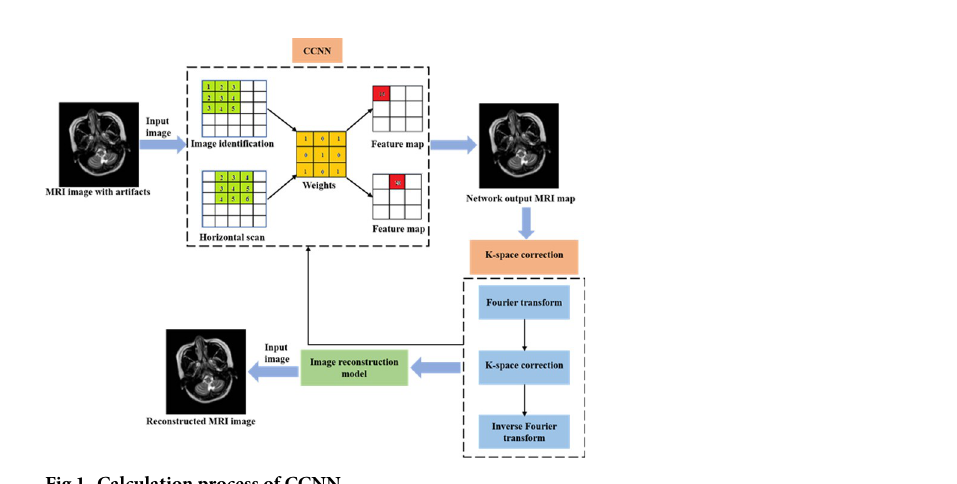
Fig 1. Calculation process of